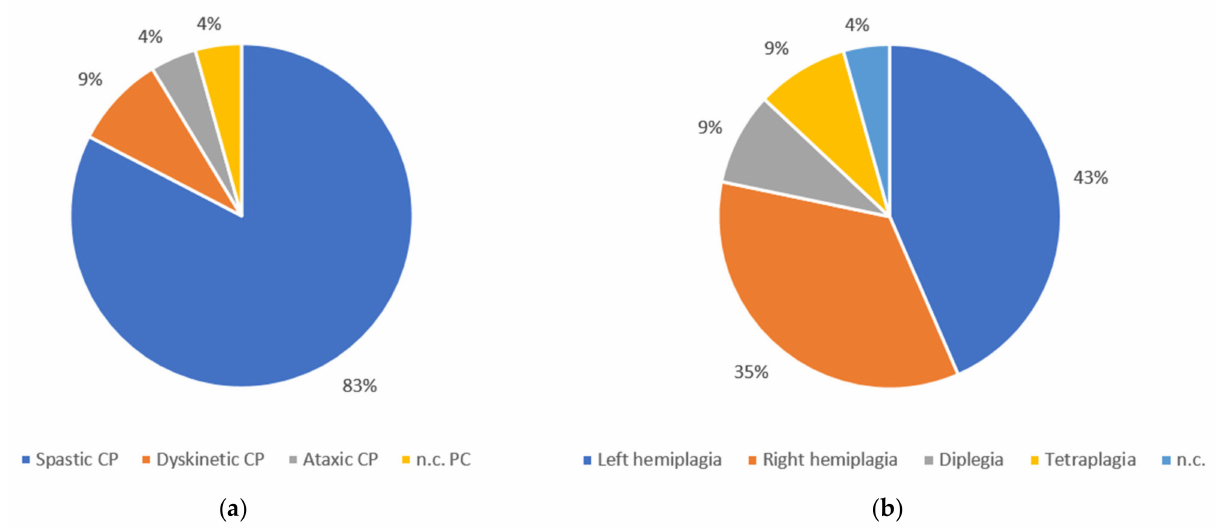
Figure 3. Distribution of children reached by the survey who have cerebral palsy. In ( a ), children are grouped according to the CP form, while in ( b ) according to the CP